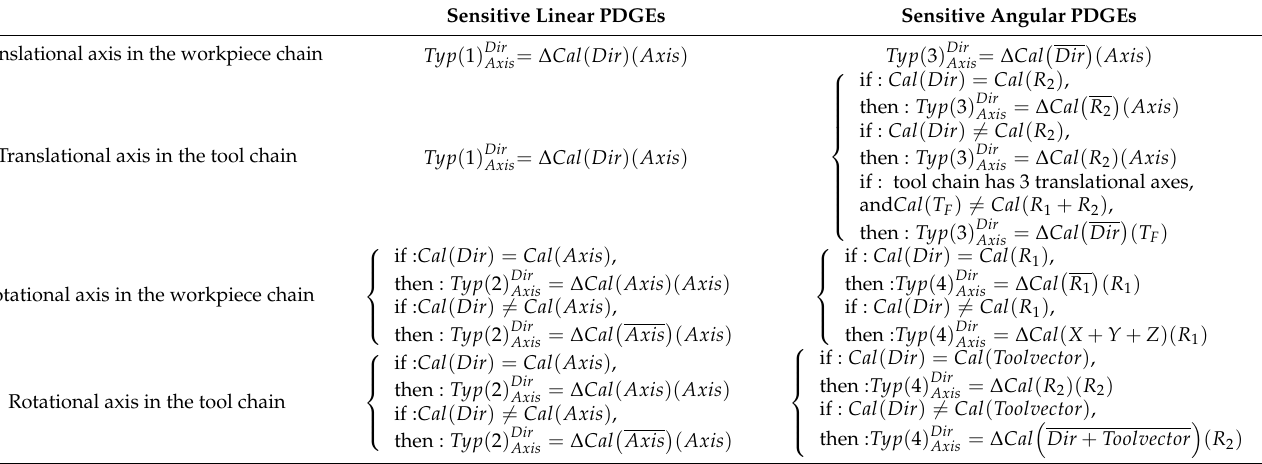
Table 3. Mapping expressions of RTTTR-type five-axis machine tool.